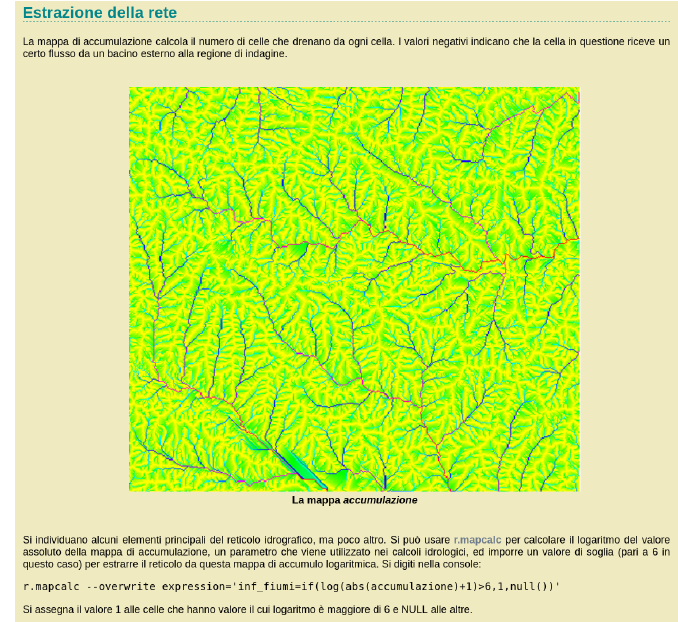
Figure 1. GRASS tutorial: watershed analysis and basins